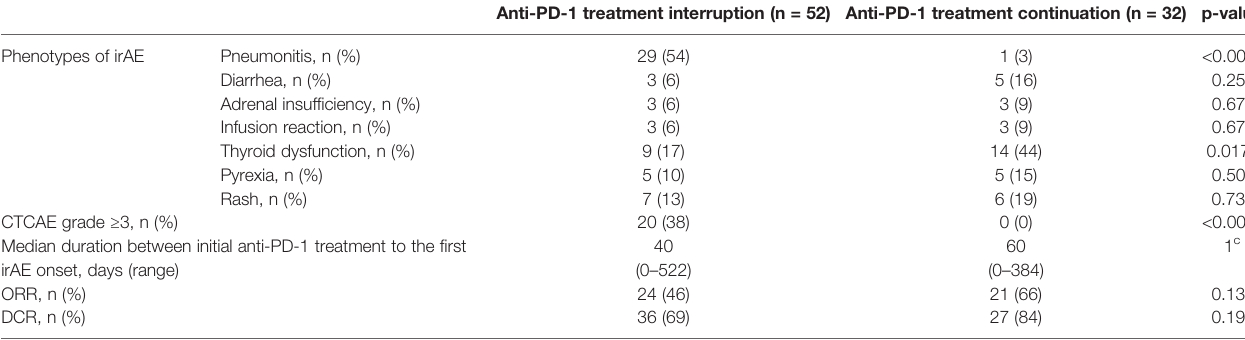
TABLE 4 | Characteristics of the initial irAEs and clinical courses, related treatment interruption.